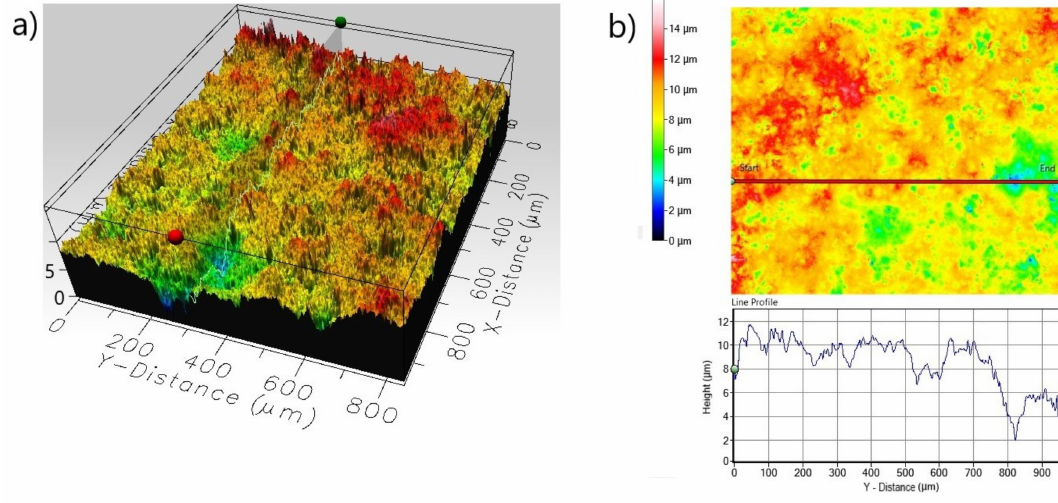
Figure 15. 3D profile ( a ) and 2D profile ( b ) of the corroded surface of borided Nimonic ® 80A alloy after the corrosion resistance test in a 3.5% NaCl